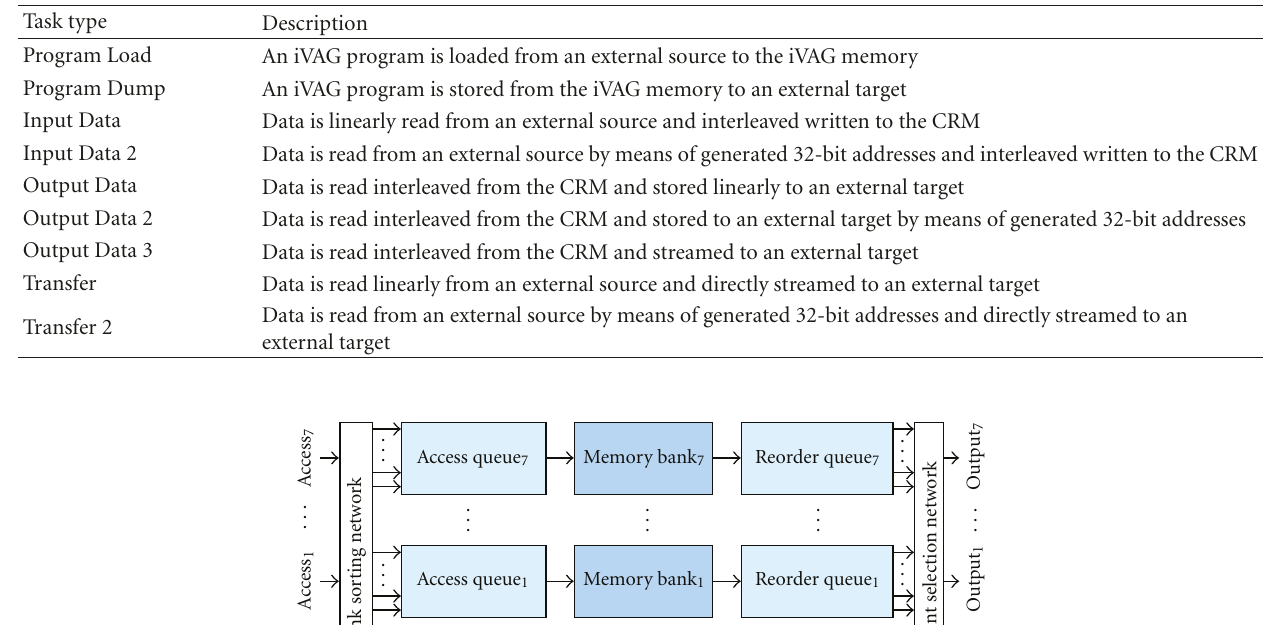
Table 2: Task type overview.